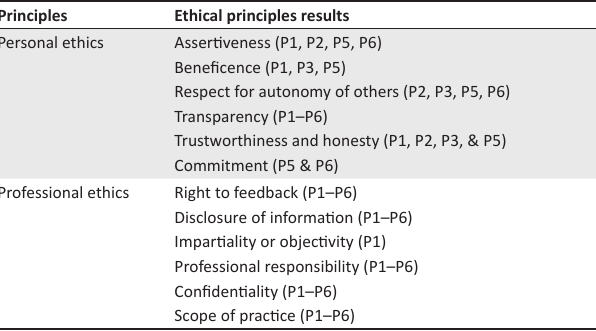
TABLE 2: Personal and professional ethical principles as indicated by the